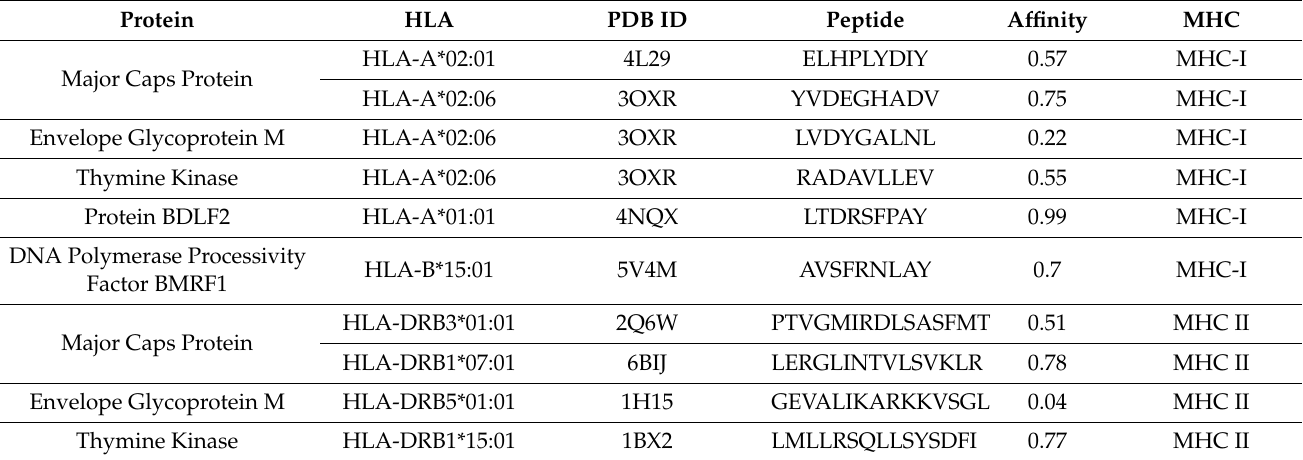
Table 5. Selected T cell epitopes, HLA molecules, and binding affinity towards the respective